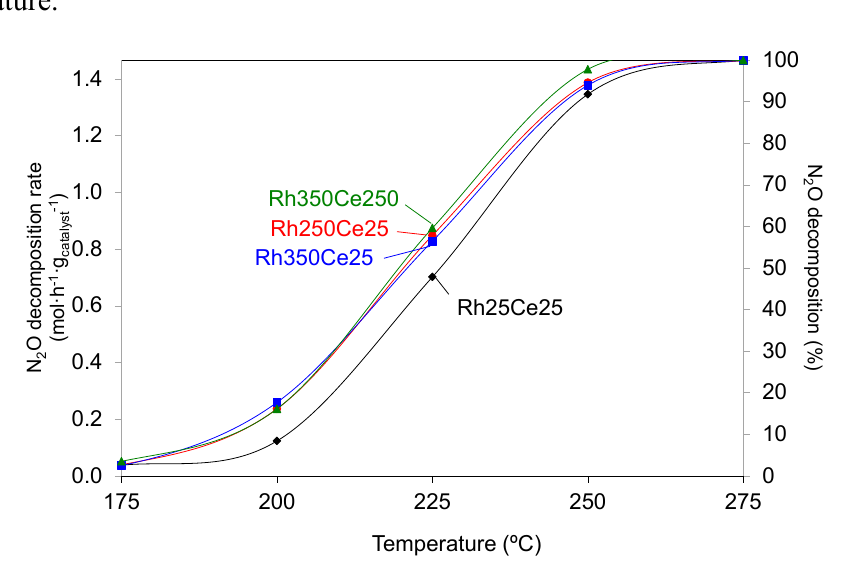
Figure 4. Steady-state N 2 O decomposition rates and conversions as a function of